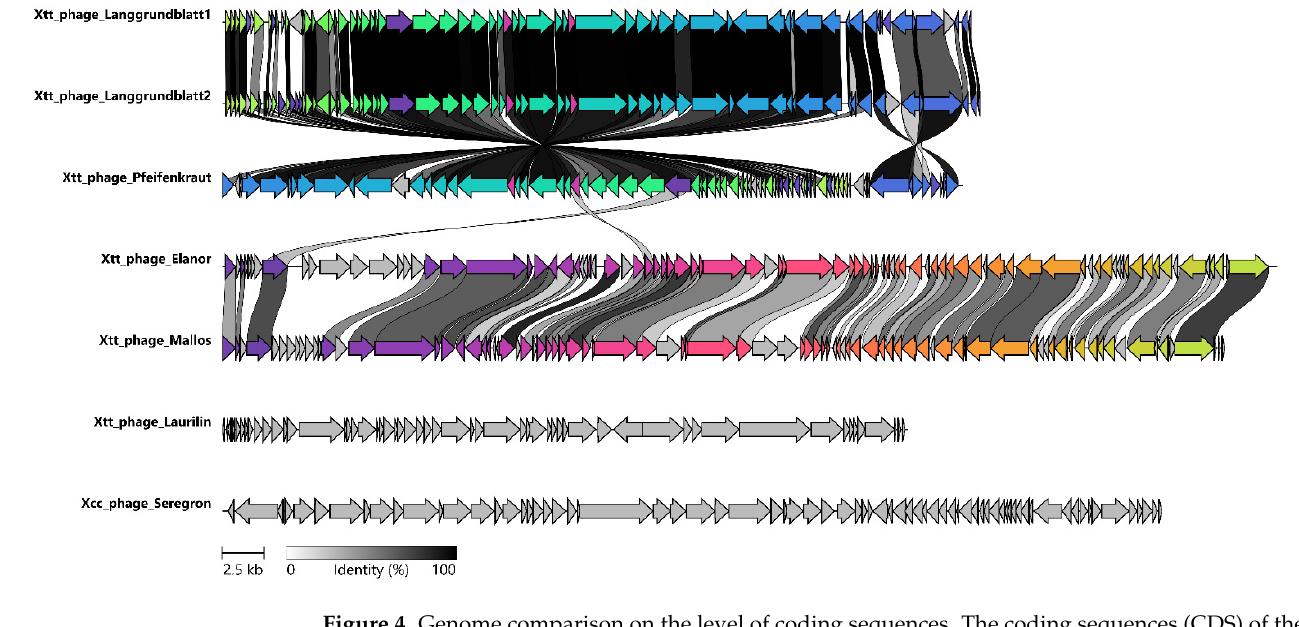
Figure 4. Genome comparison on the level of coding sequences. The coding sequences (CDS) of the isolated phages were compared using the clinker pipeline [60] to cluster them in groups by similarity (each colour represents one group) and per cent identity of the member of one group is indicated by grey values. The circular genomes are represented linearly and the direction of the arrows is in line with transcription direction of each CDS.